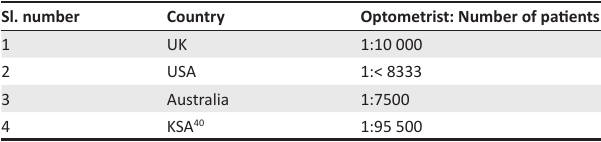
TABLE 1: Comparison ratios of optometrists to patients in different countries and Saudi Arabia (American Academy of Optometry), 2008. 35 Sl.